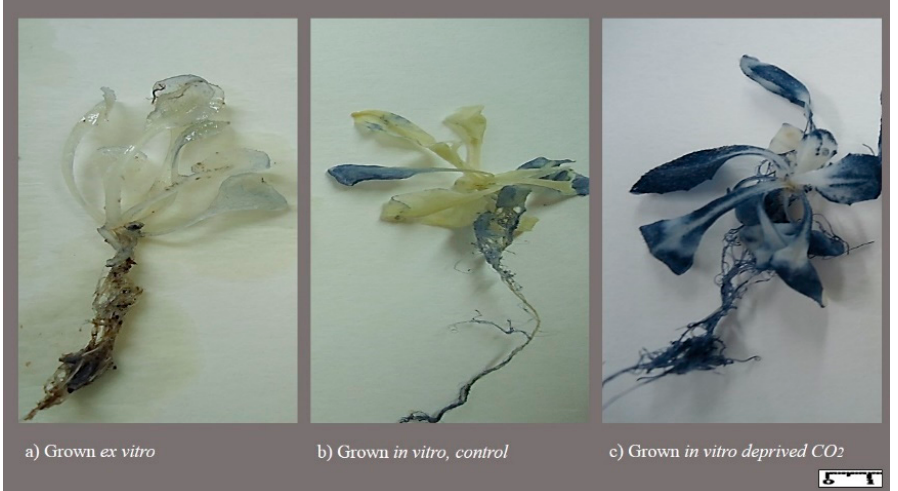
Figure 5. Arabidopsis seedlings stained with NBT ( a ) grown ex vitro, ( b ) grown in vitro under control conditions, and ( c ) grown in vitro under conditions when (most) of the CO 2 had been removed. Bar = 10 mm.